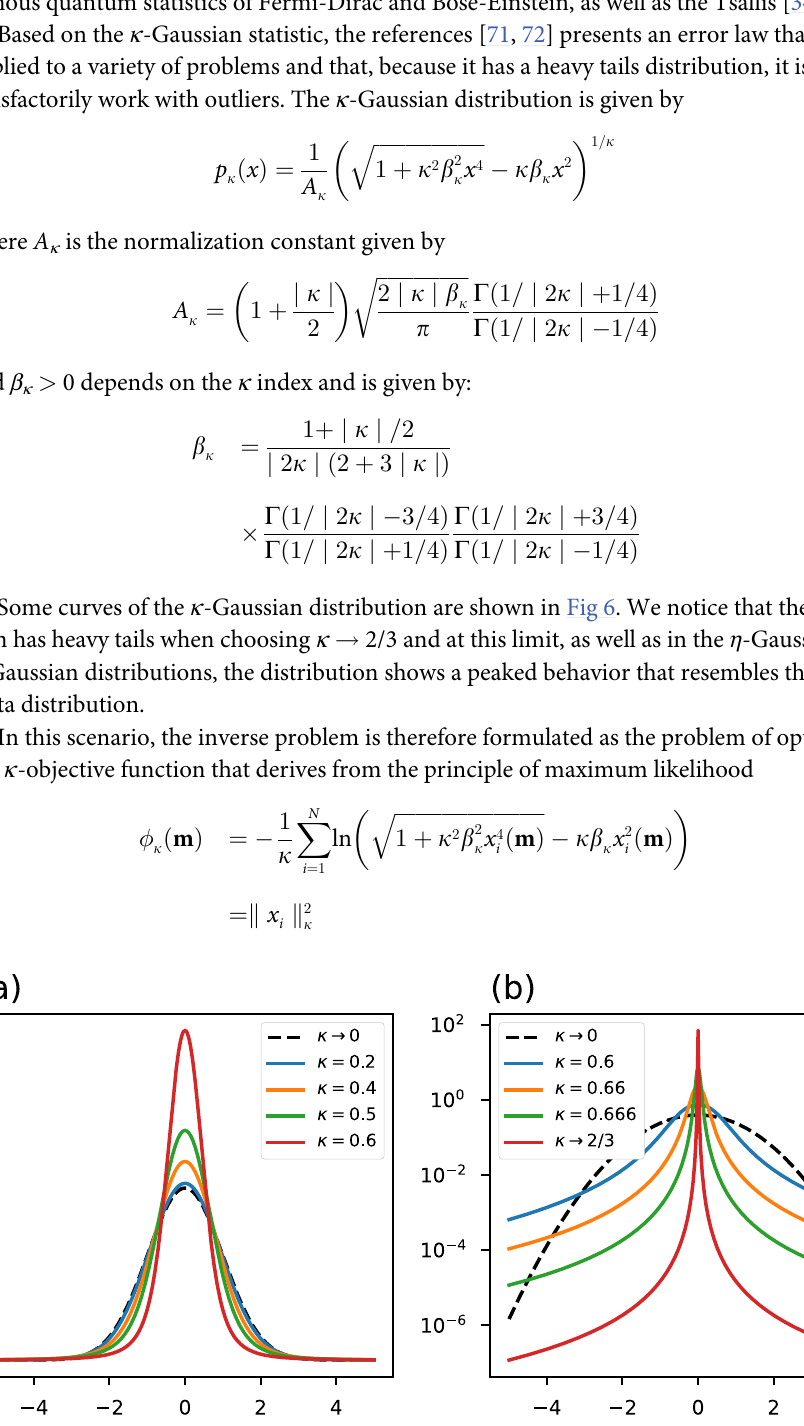
Fig 6. κ -Gaussian probability distribution. The black dashed line represents the conventional